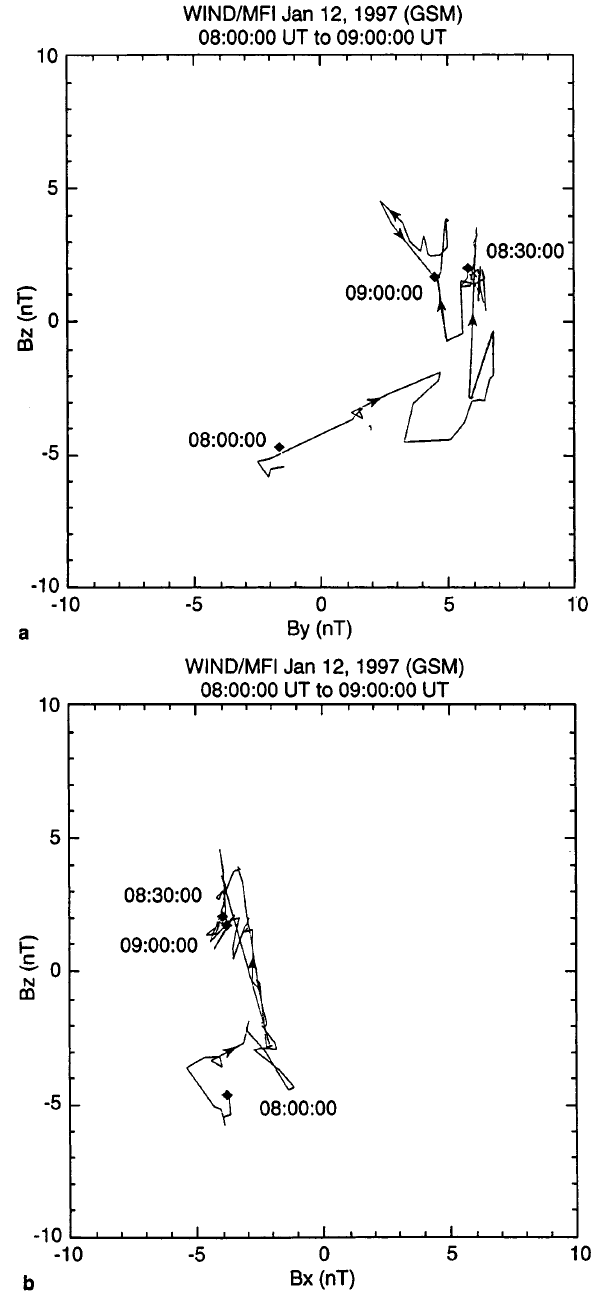
Fig. 4a, b. IMF orientations illustrated by hodograms in the a YZ and b XZ GSM planes for the interval 08-09 UT. The dots are for 08:00, 08:30